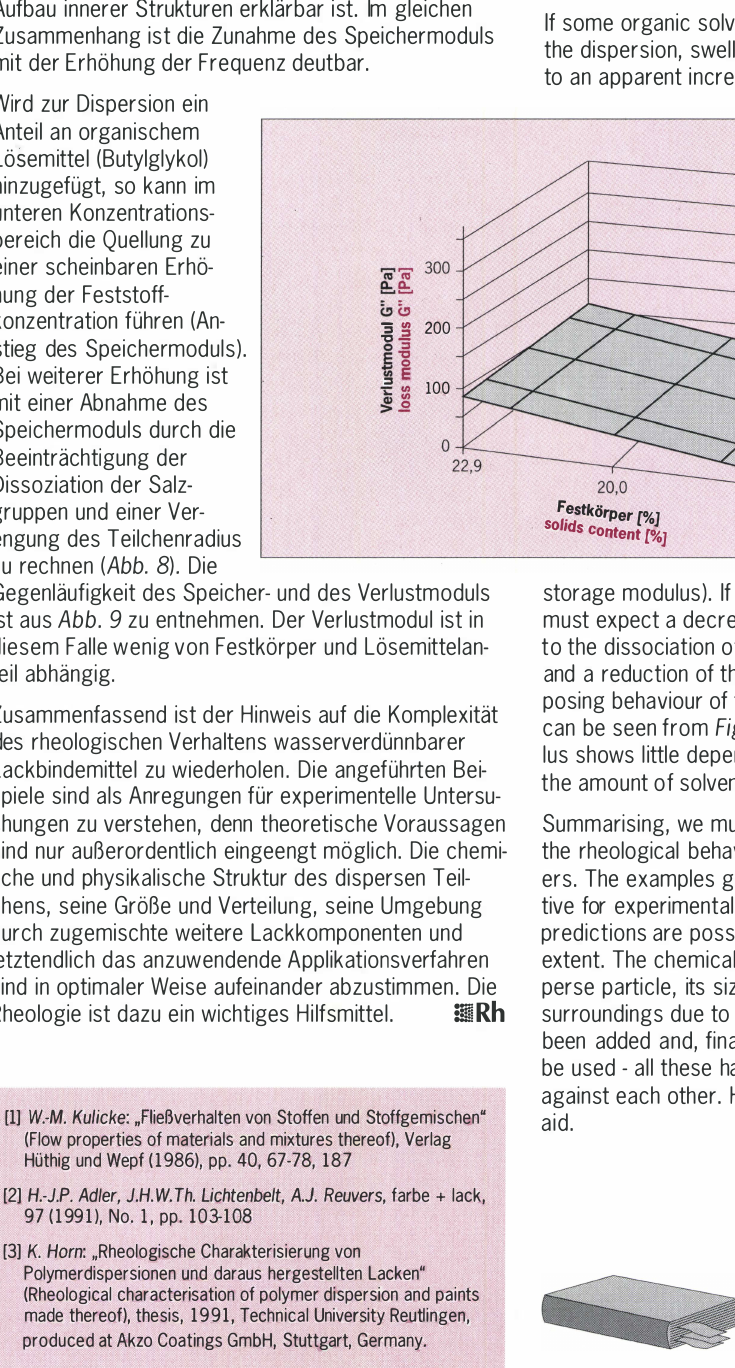
tion, which can be ex­ plained by the build-up of internal structures. Simi­ larly, the increase in stor­ age modulus is the result of increased frequency.